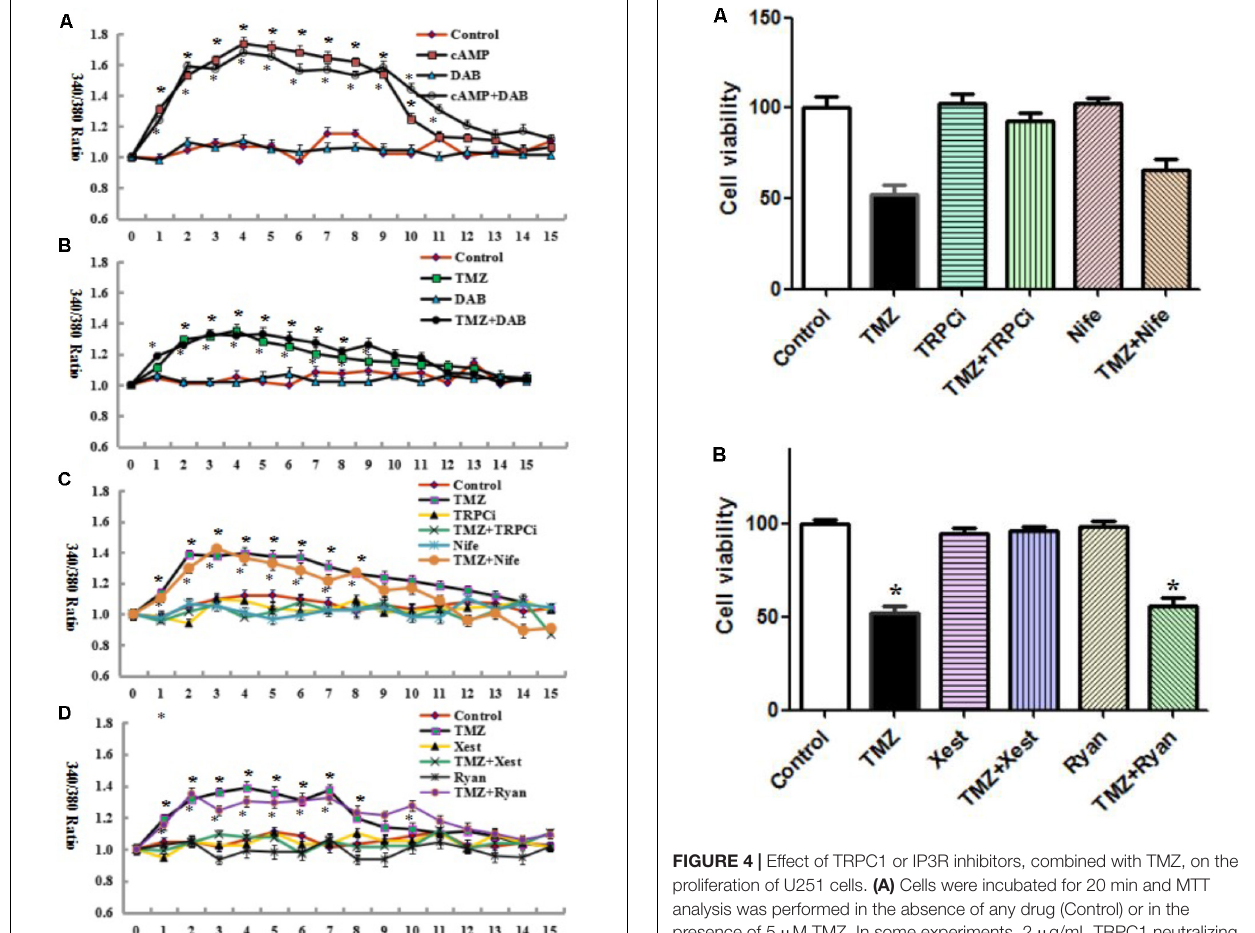
GPBB concentration was maximal at the optimal cut-off value of 30.71. For the group, as the cut-off value of plasma GPBB concentration was increased from 30.71 to 31.04, the